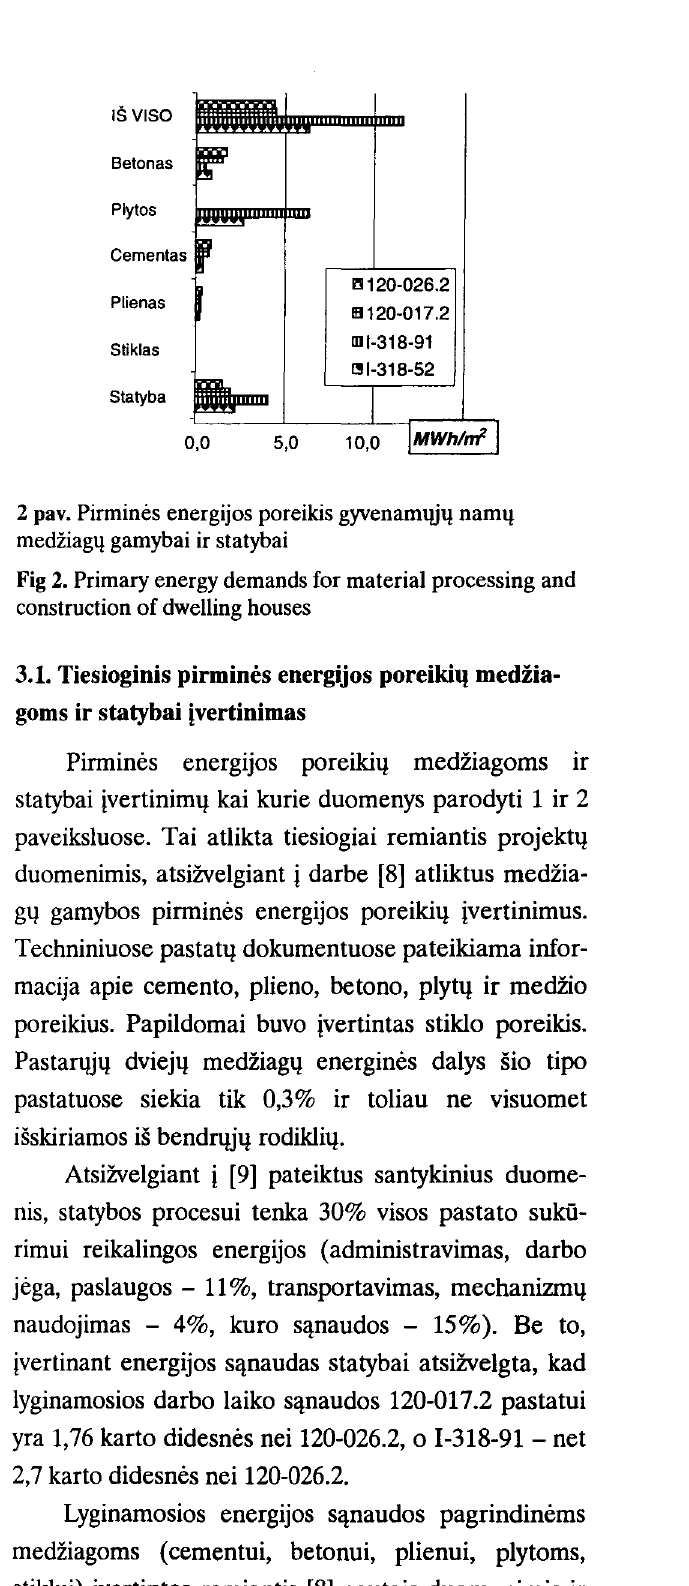
Fig 1. Primary energy demands of five-storey brick houses for material processing and construction